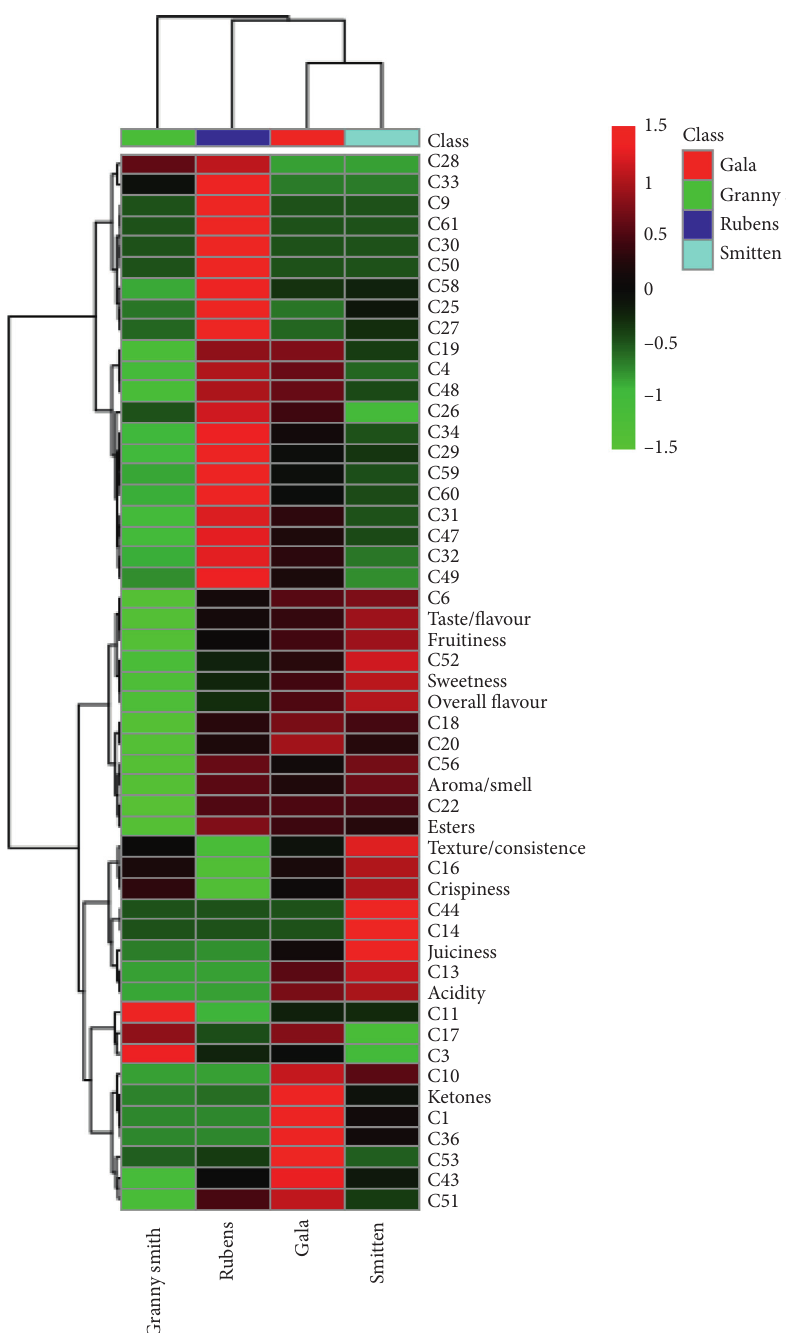
Figure 4: Two-way hierarchical clustering heatmap of cultivars for volatile compounds (represented as codes; full VOC name can be found in Table 1) and sensorial attributes. Green indicates a low content, black, intermediate, and red, high, for each